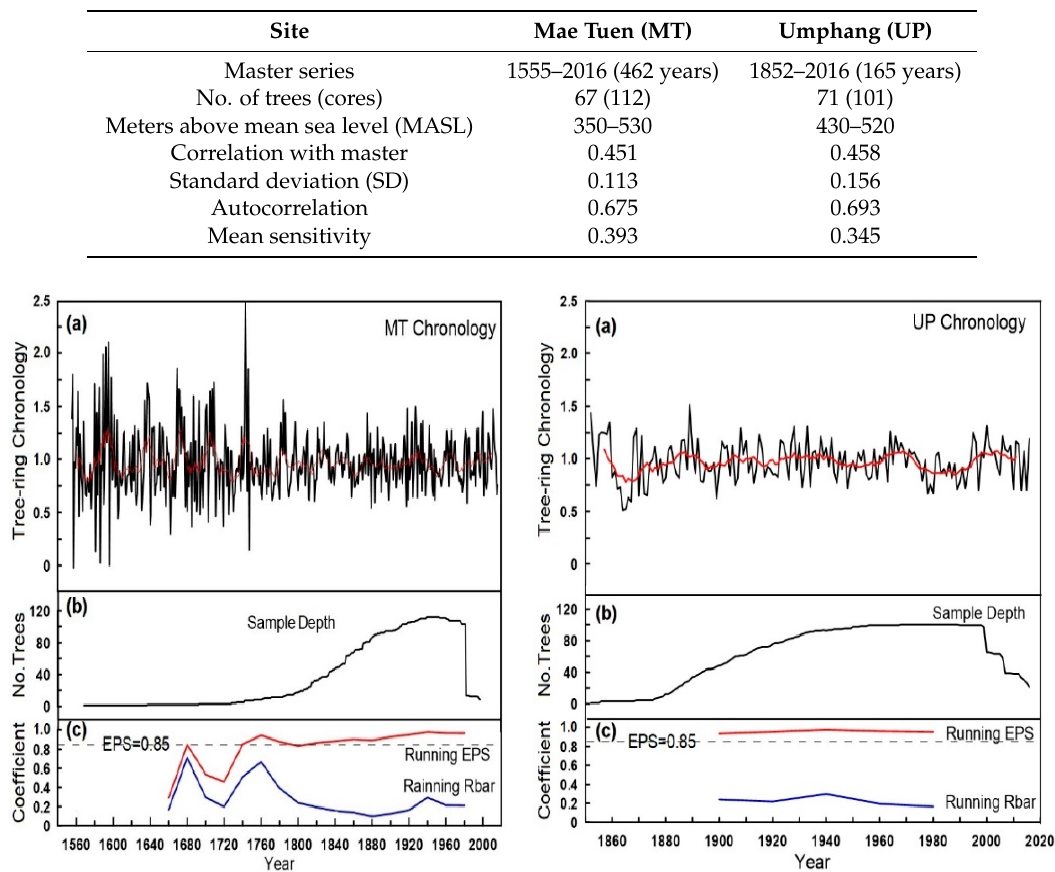
Figure 2. (a) The MT and UP chronologies, (b) variation in tree samples size, and (c) variation in Figure 2. ( a ) The MT and UP chronologies, ( b ) variation in tree samples size, and ( c ) variation in running expressed population signal (EPS) and mean series inter-correlation (Rbar). running expressed population signal (EPS) and mean series inter-correlation